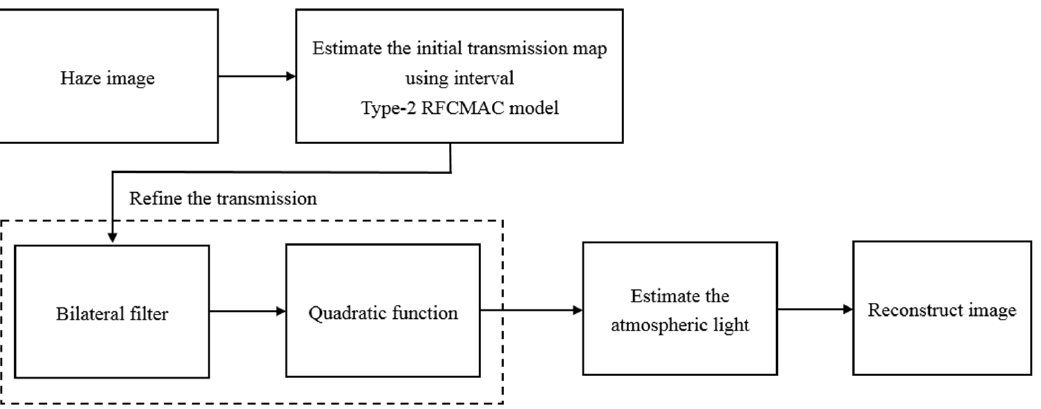
Figure 1. Flowchart of image dehazing process.